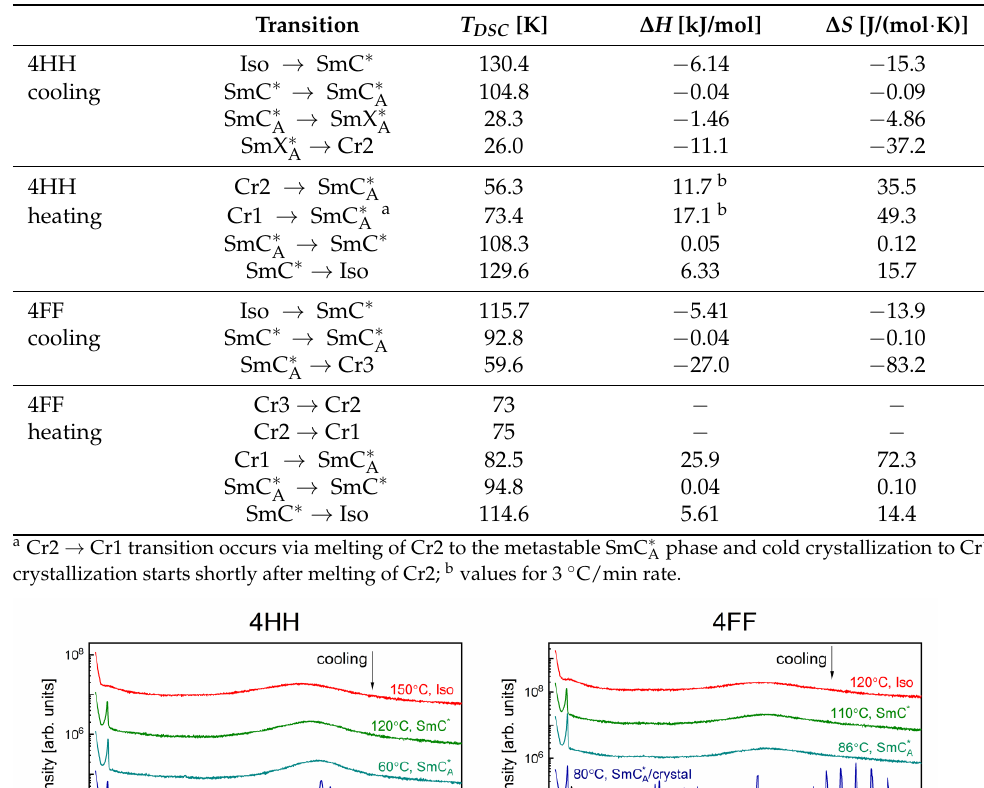
Table 1. Phase transition temperatures (obtained from the linear extrapolation of the onset tem- peratures to 0 °C/min rate) and the corresponding energy effects for 4HH and 4FF.